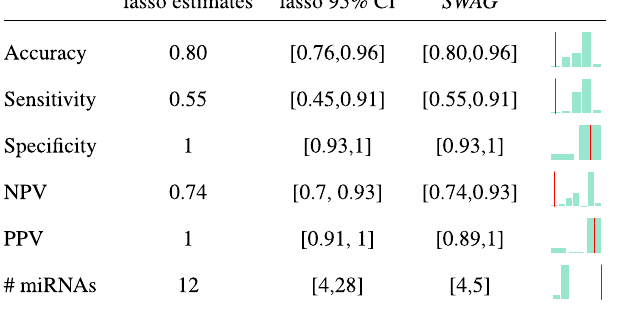
Figure 2. Comparison between Lasso and SWAG . We compare accuracy, sensitivity, specificity, negative predictive value (NPV), positive predictive value (PPV), number (#) of miRNAs of the lasso estimates (and relative 95% percentile bootstrap confidence intervals) with the ranges (i.e. smallest-to-largest value intervals) of the same metrics for the 112 SWAG models. On the right of each SWAG range, a barplot illustrates the distribution of the specific metrics for the 112 considered models with a vertical red line representing the corresponding value for the lasso. All evaluations have been made out-of-sample (i.e. on the test set) at the standard 0.5 cut-off of logistic regression.